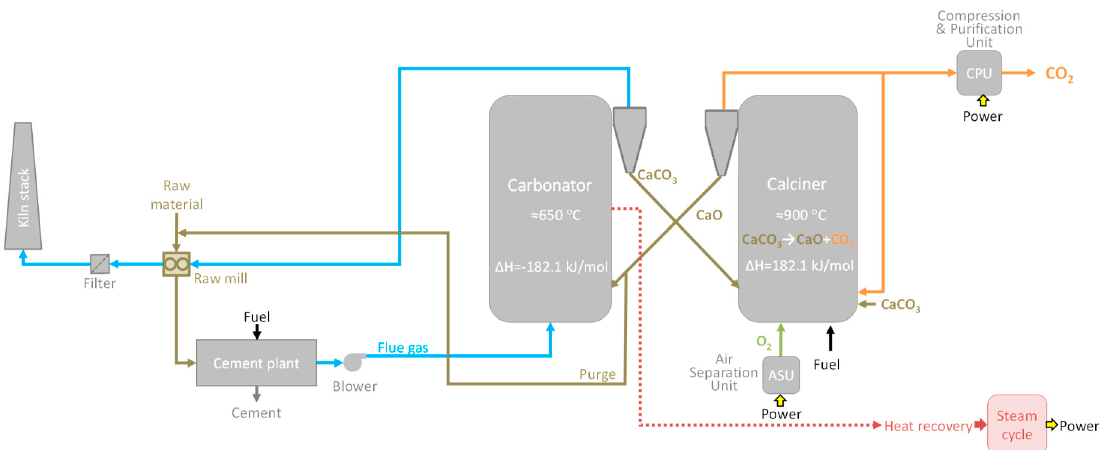
Figure 11. Simplified diagram flow of a CaL process installed in a cement plant: tail-end configuration (adapted from [46]).